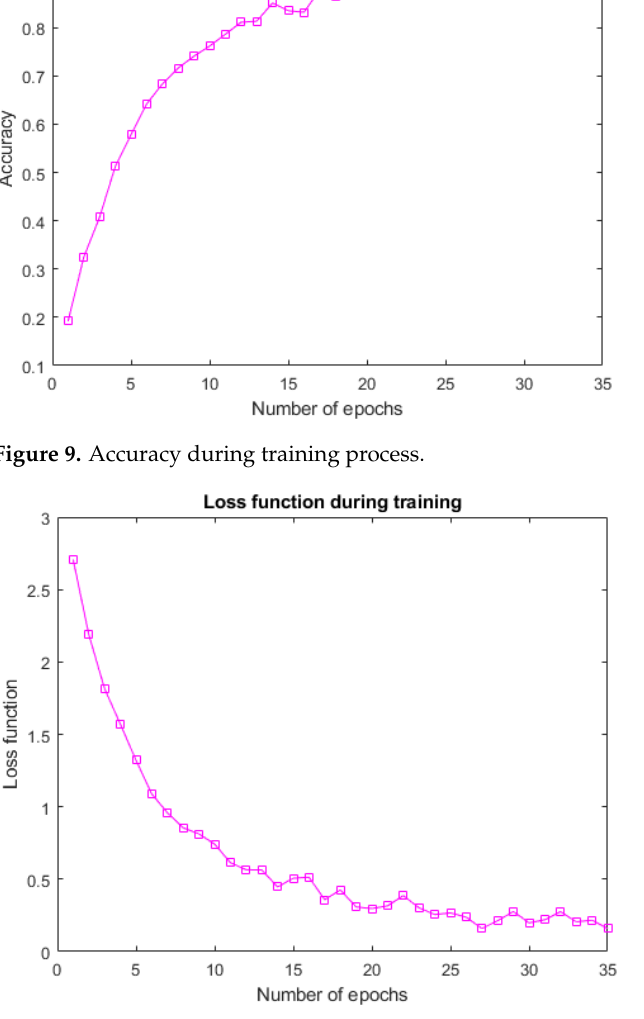
Figure 10. Loss function during training